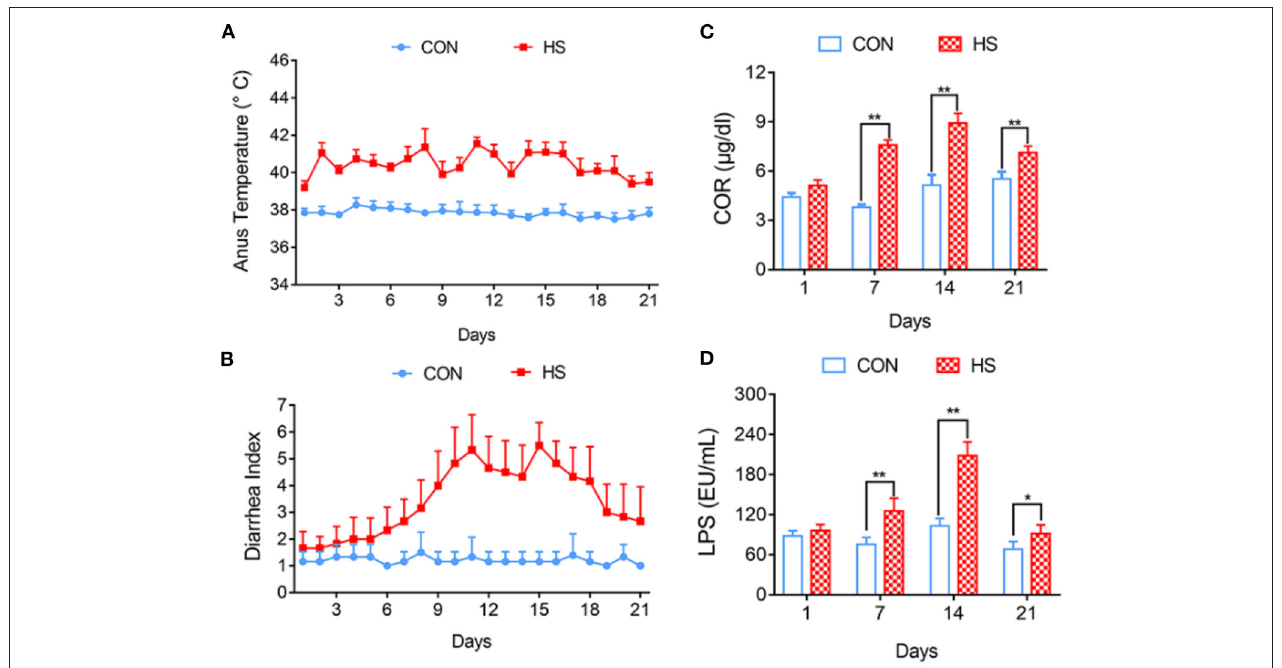
FIGURE 1 | Effects of heat stress on pig anus temperature and growth performance. (A) Anus temperature; (B) Diarrhea Index; (C) Concentration of COR in Peripheral blood; (D) Concentration of ET in Peripheral blood. * p < 0.05, ** p < 0.01 compared with each group.